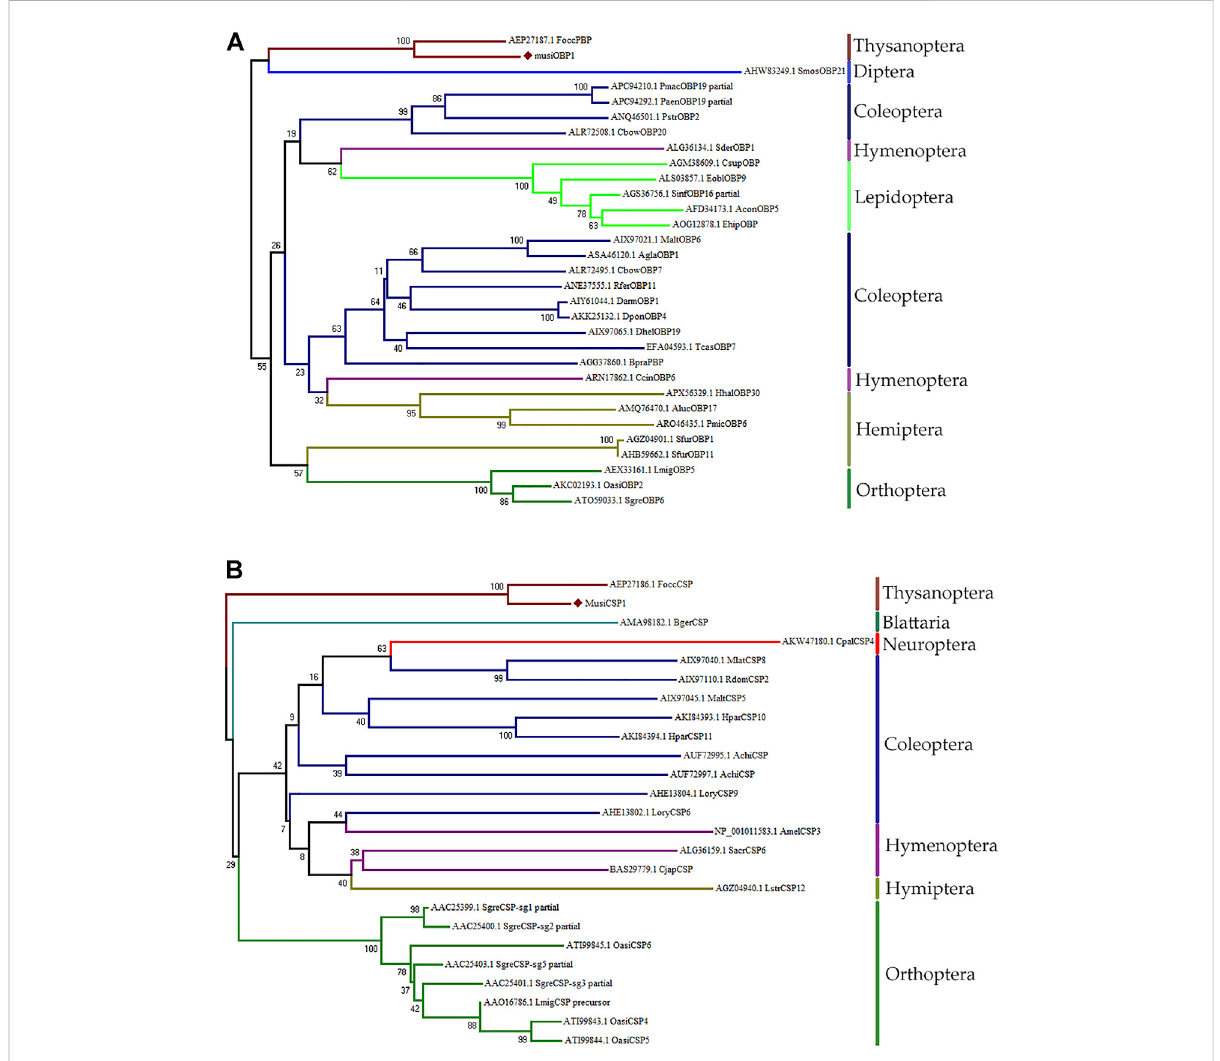
FIGURE 4 AminoacidsequencephylogenetictreeconstructionusingtheNJmethod. (A) MusiOBP1andotherinsectOBPs. (B) MusiCSP1andotherinsect